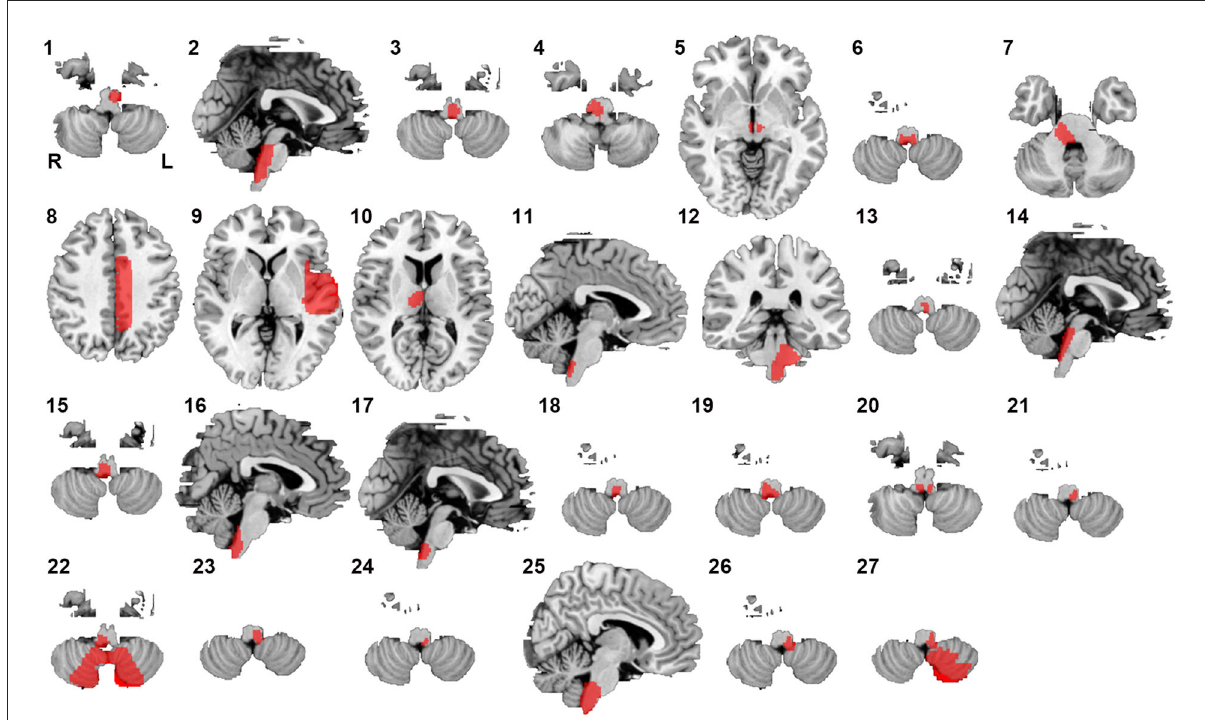
FIGURE1 Lesions causing CSA. Twenty-seven lesions causing CSA were mapped onto a standardized brain atlas.